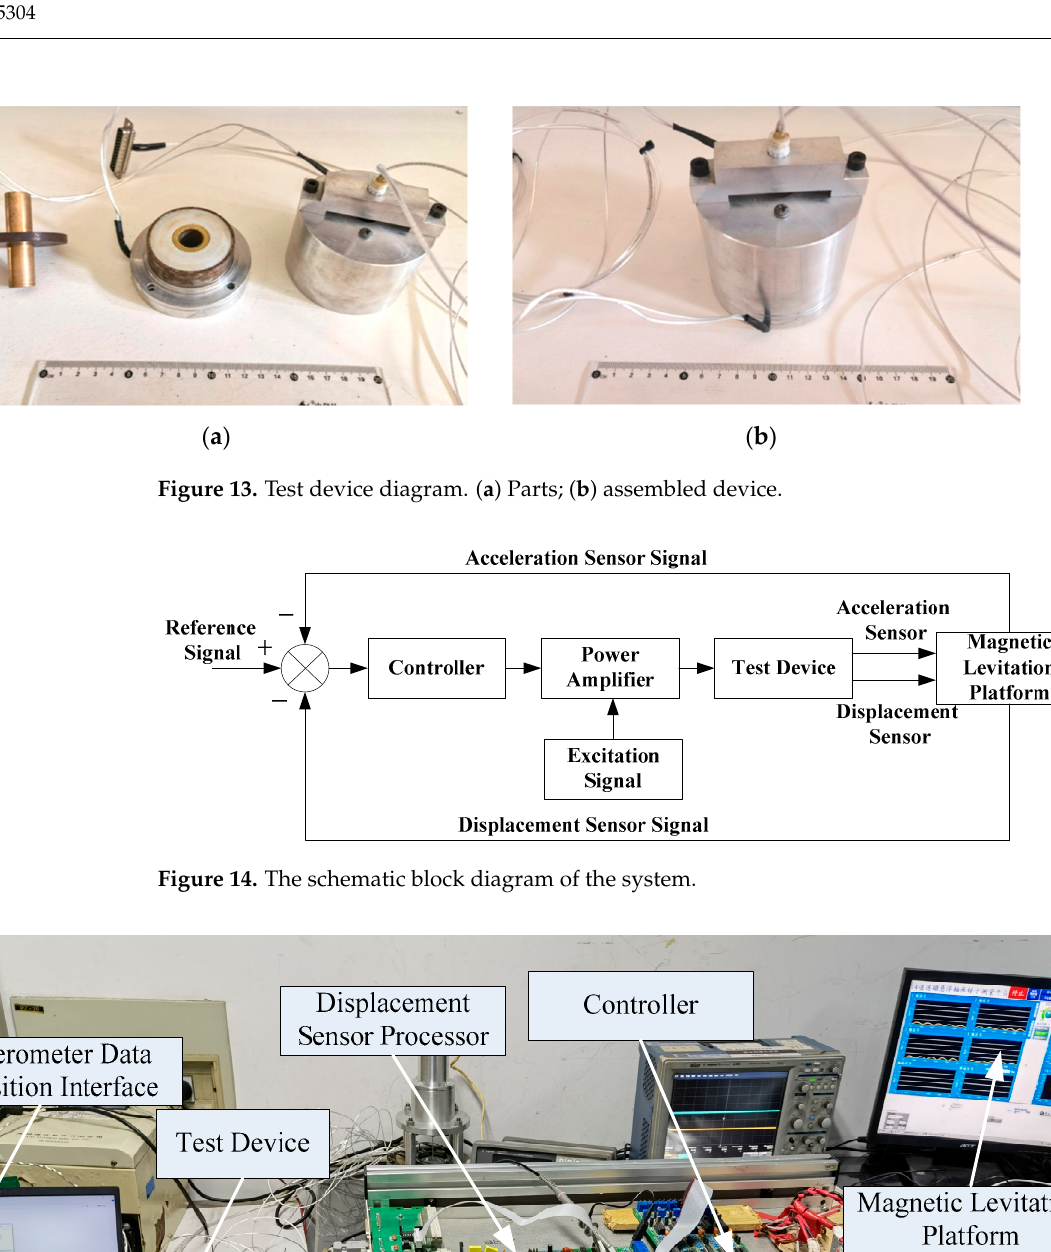
Figure 15. Test device and signal acquisition.